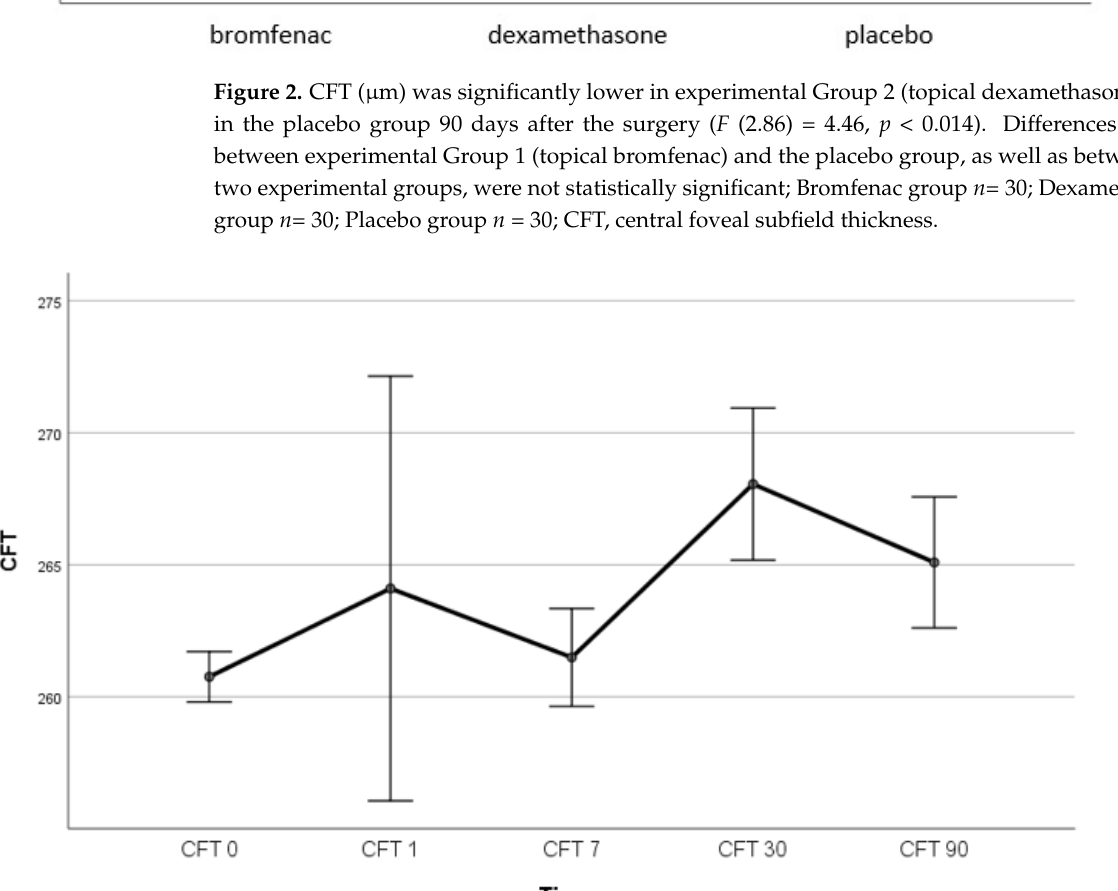
Figure 3. CFT ( µ m) peaked one month after surgery, but the difference was not statistically significant ( F (1.264, 108.75) = 0.498, p = 0.525); n = 90; CFT, central foveal subfield thickness; CFT 0, central foveal subfield thickness on the day of the surgery; CFT 1, central foveal subfield thickness on first postoperative day; CFT 7, central foveal subfield thickness seven days after surgery; CFT 30, central foveal subfield thickness 30 days after surgery; CFT 90, central foveal subfield thickness 90 days after surgery.